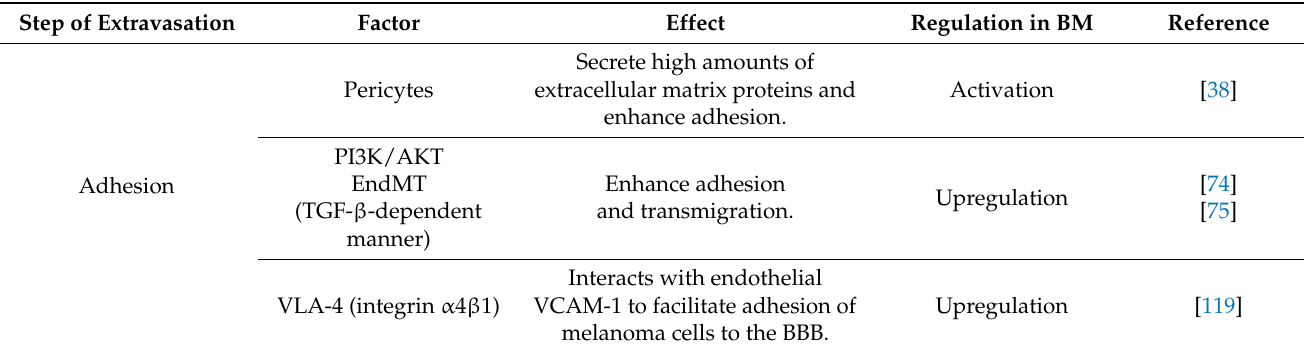
Table 3. Factors that mediate extravasation during brain metastasis of